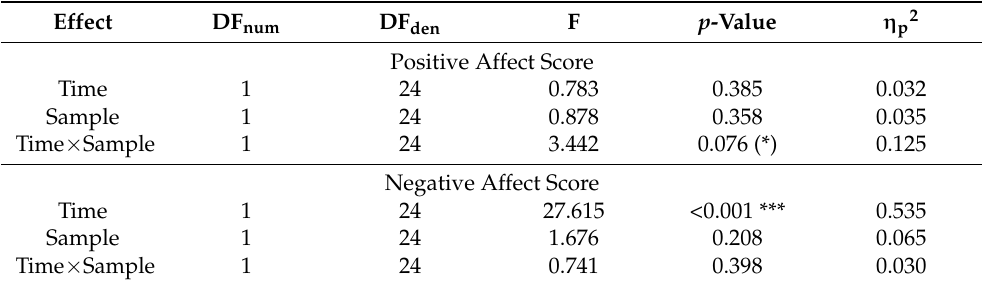
Table 2. Results of rm ANOVA on the positive and negative affect with the factors time (before and after product and placebo application) and sample (AC and PL) (N = 25).